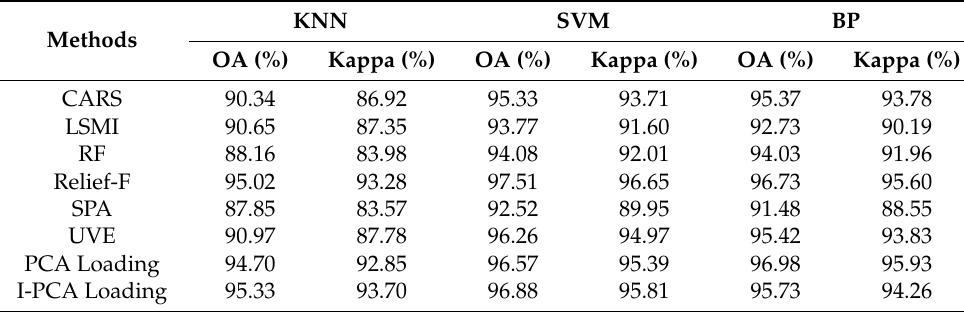
Table 5. Classification results of feature wavelength selection